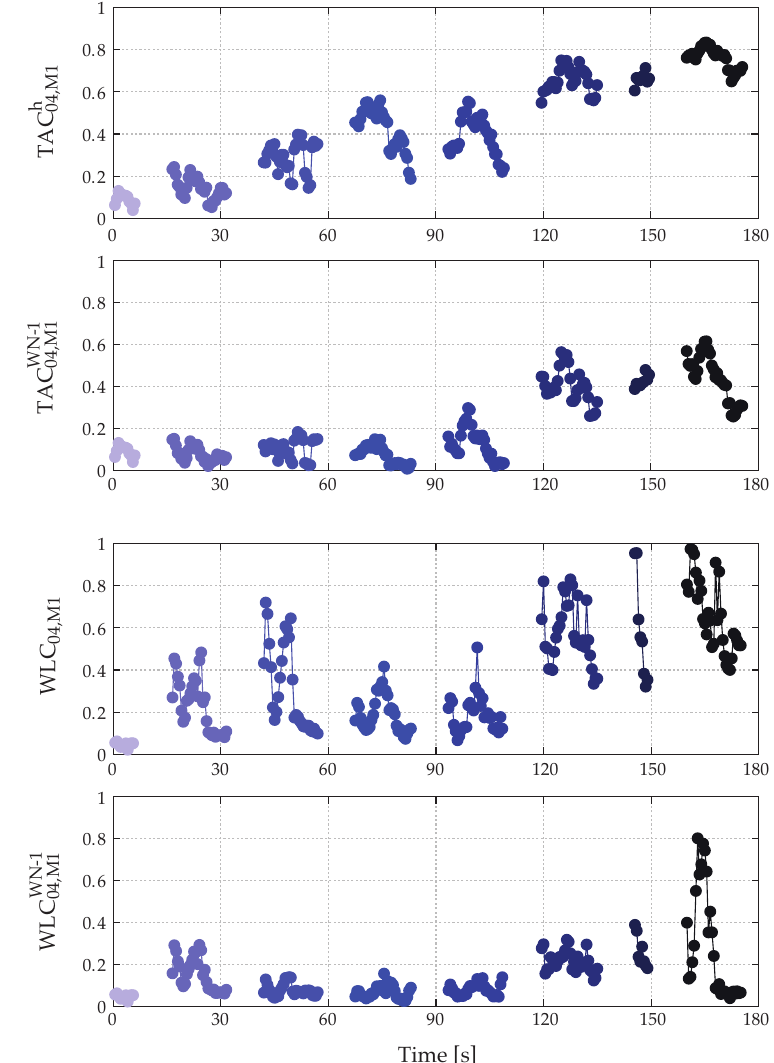
Figure 17. Evolution of DSFs with time over the sequence of eight GM signals. Absolute ( top ) and relative ( second row ) value of TAC , as well as absolute ( third row ) and relative ( bottom ) value of WLC are shown.